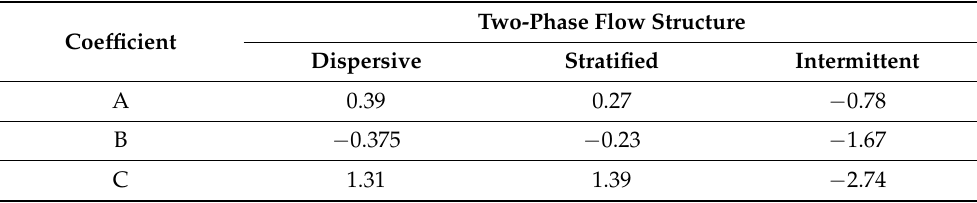
Table 4. The value of the coefficients A, B and C in the Equations (1) and (2). Two-Phase Flow Structure Coefficient Dispersive Stratified